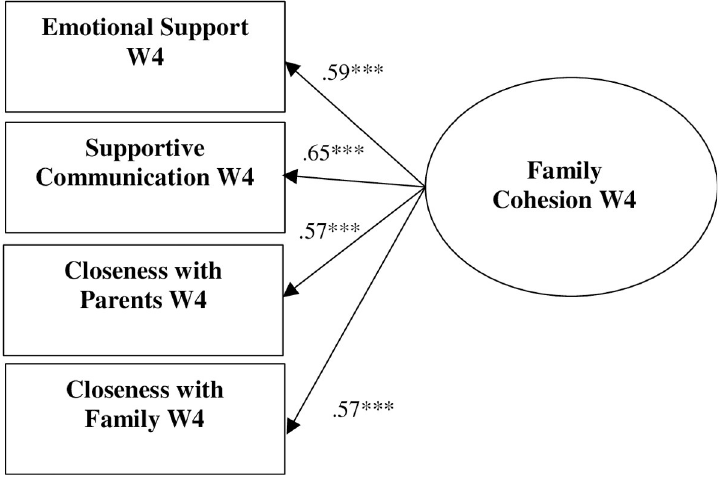
Fig 1. Measurement model for family cohesion W4. Standardized results are presented. � p < .05 (two-tailed). �� p < .01 (two-tailed). ��� p < .001